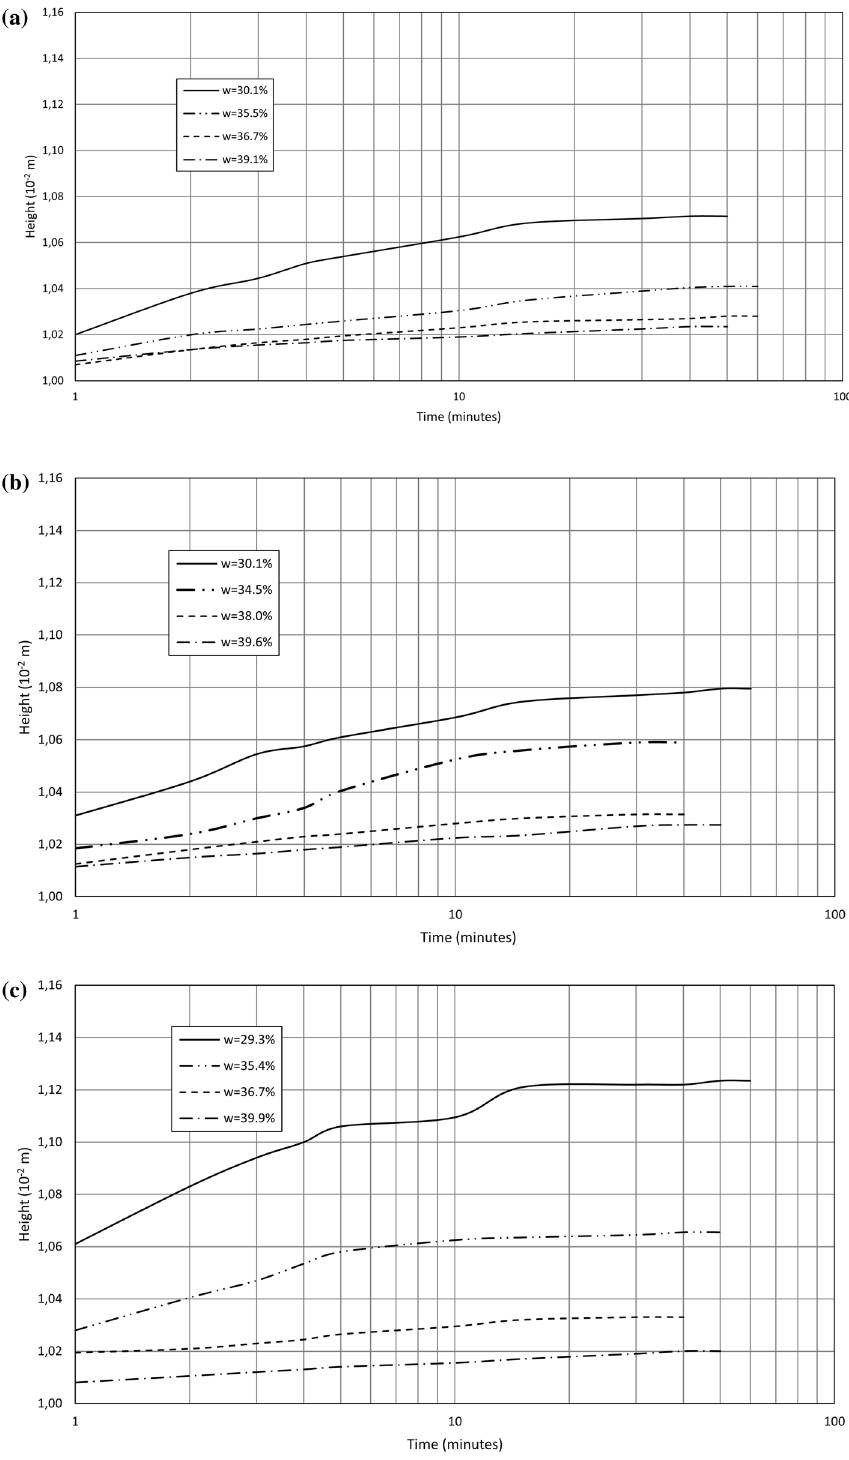
Figure 3. Sample height change versus log time for swell testing in ( a ) distilled water, ( b ) tap water, and ( c )